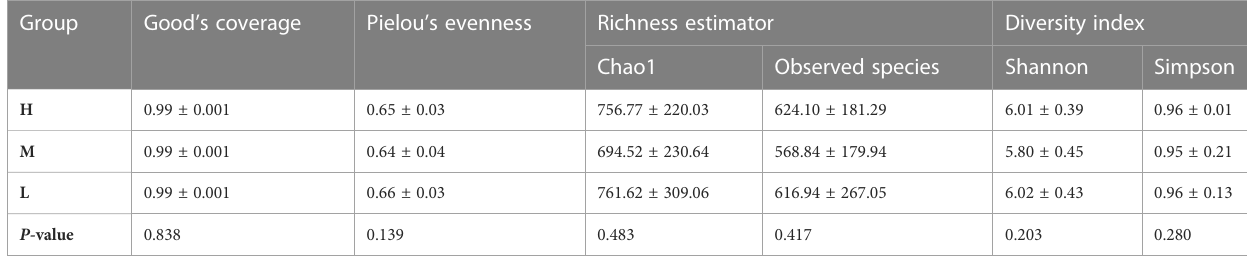
TABLE 2 Comparison of species alpha diversity based on ASV levels among different CA groups.